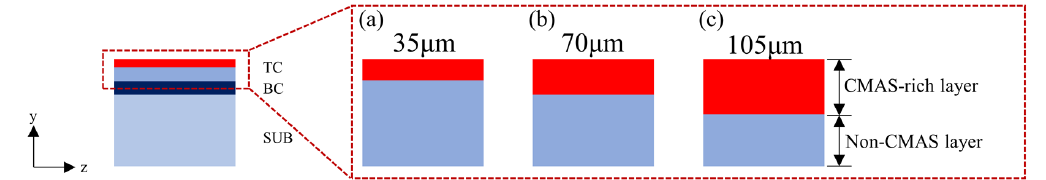
Figure 7. Outlined diagram for illustrating ( a ) 35, ( b ) 70, and ( c ) 105 μ m penetration depths of CMAS infiltration with the TC layer.